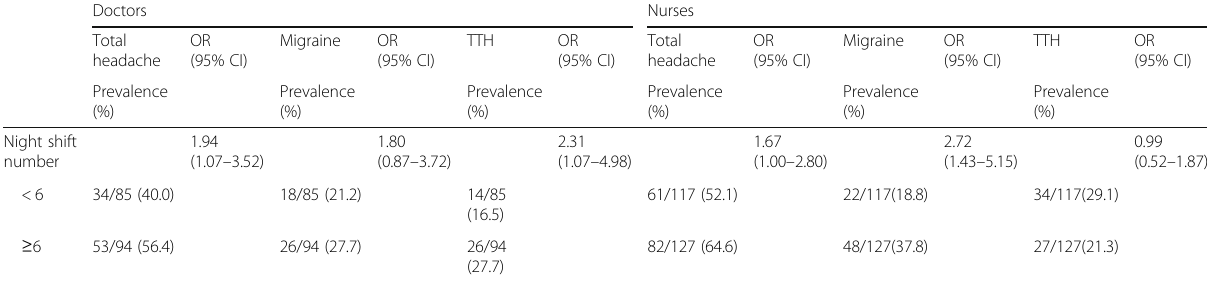
Table 5 The impact of number of night shifts per month on the prevalence of different types of headache among doctors and nurses